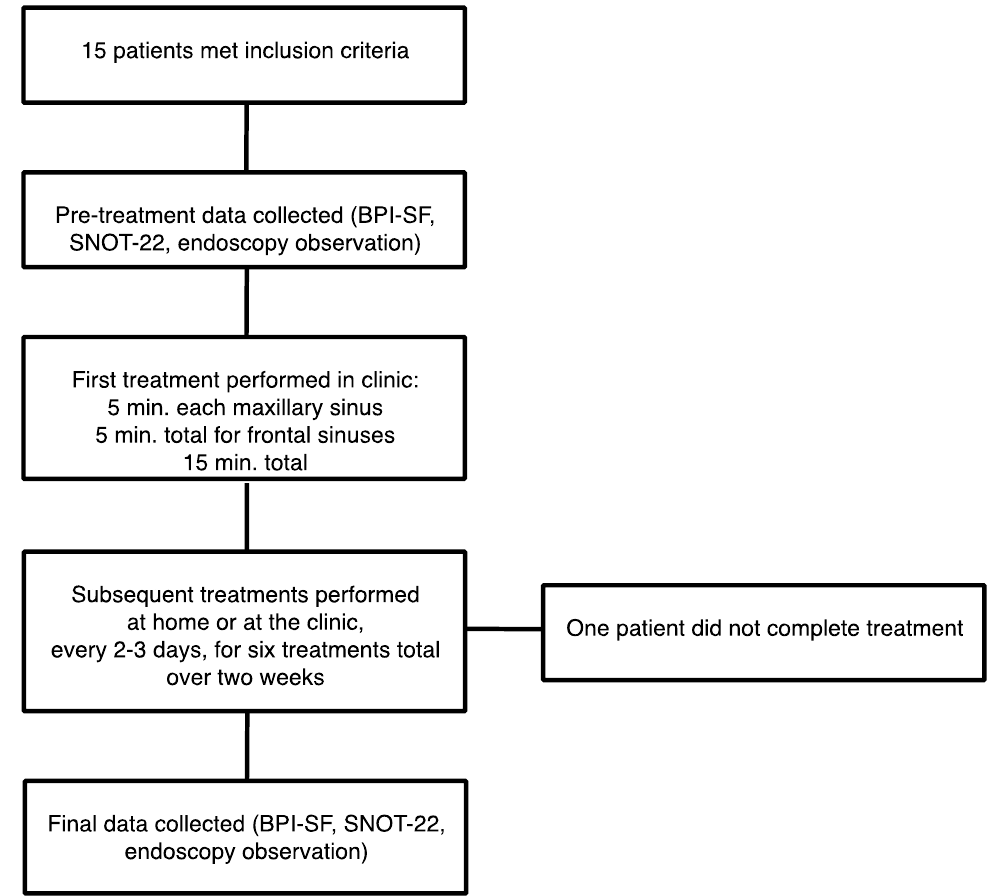
Figure 2. Clinical timeline. BPI-SF: Brief Pain Inventory Short Form; SNOT: Sino-Nasal Outcome Test. Data analysis was performed using SAS Version 9.4 (SAS Institute, Cary, NC, USA) and R Version 3.2 (R Foundation for Statistical Computing, Vienna, Austria). We compared baseline to post-treatment scores with the Wilcoxon signed rank test to avoid violations of